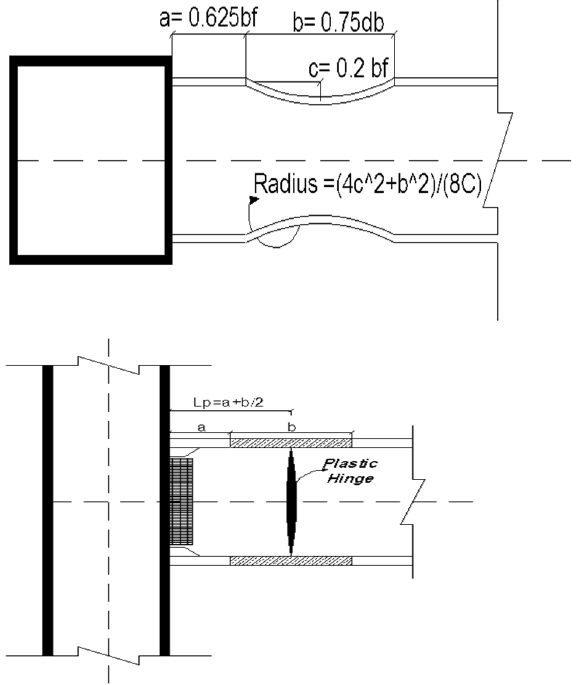
Figure 6. An overview of an example of the RBS-type connections used (conventional connections after the Northridge earthquake).